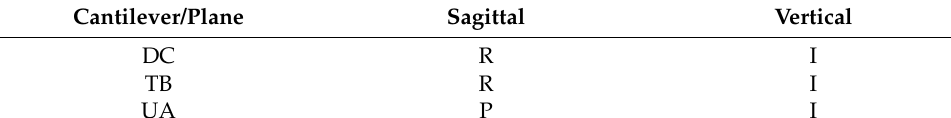
Table 1. Symmetric activation of cantilevers (R: retrusion, P: protrusion, I: intrusion).